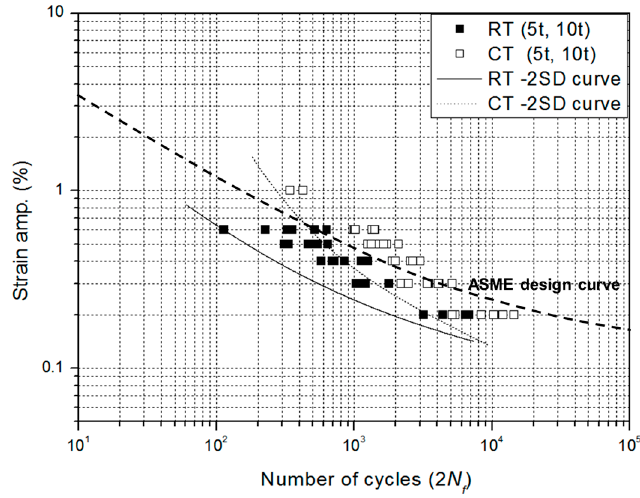
Figure 13. LCF design curve for AISI 304L welded joint at RT and CT.